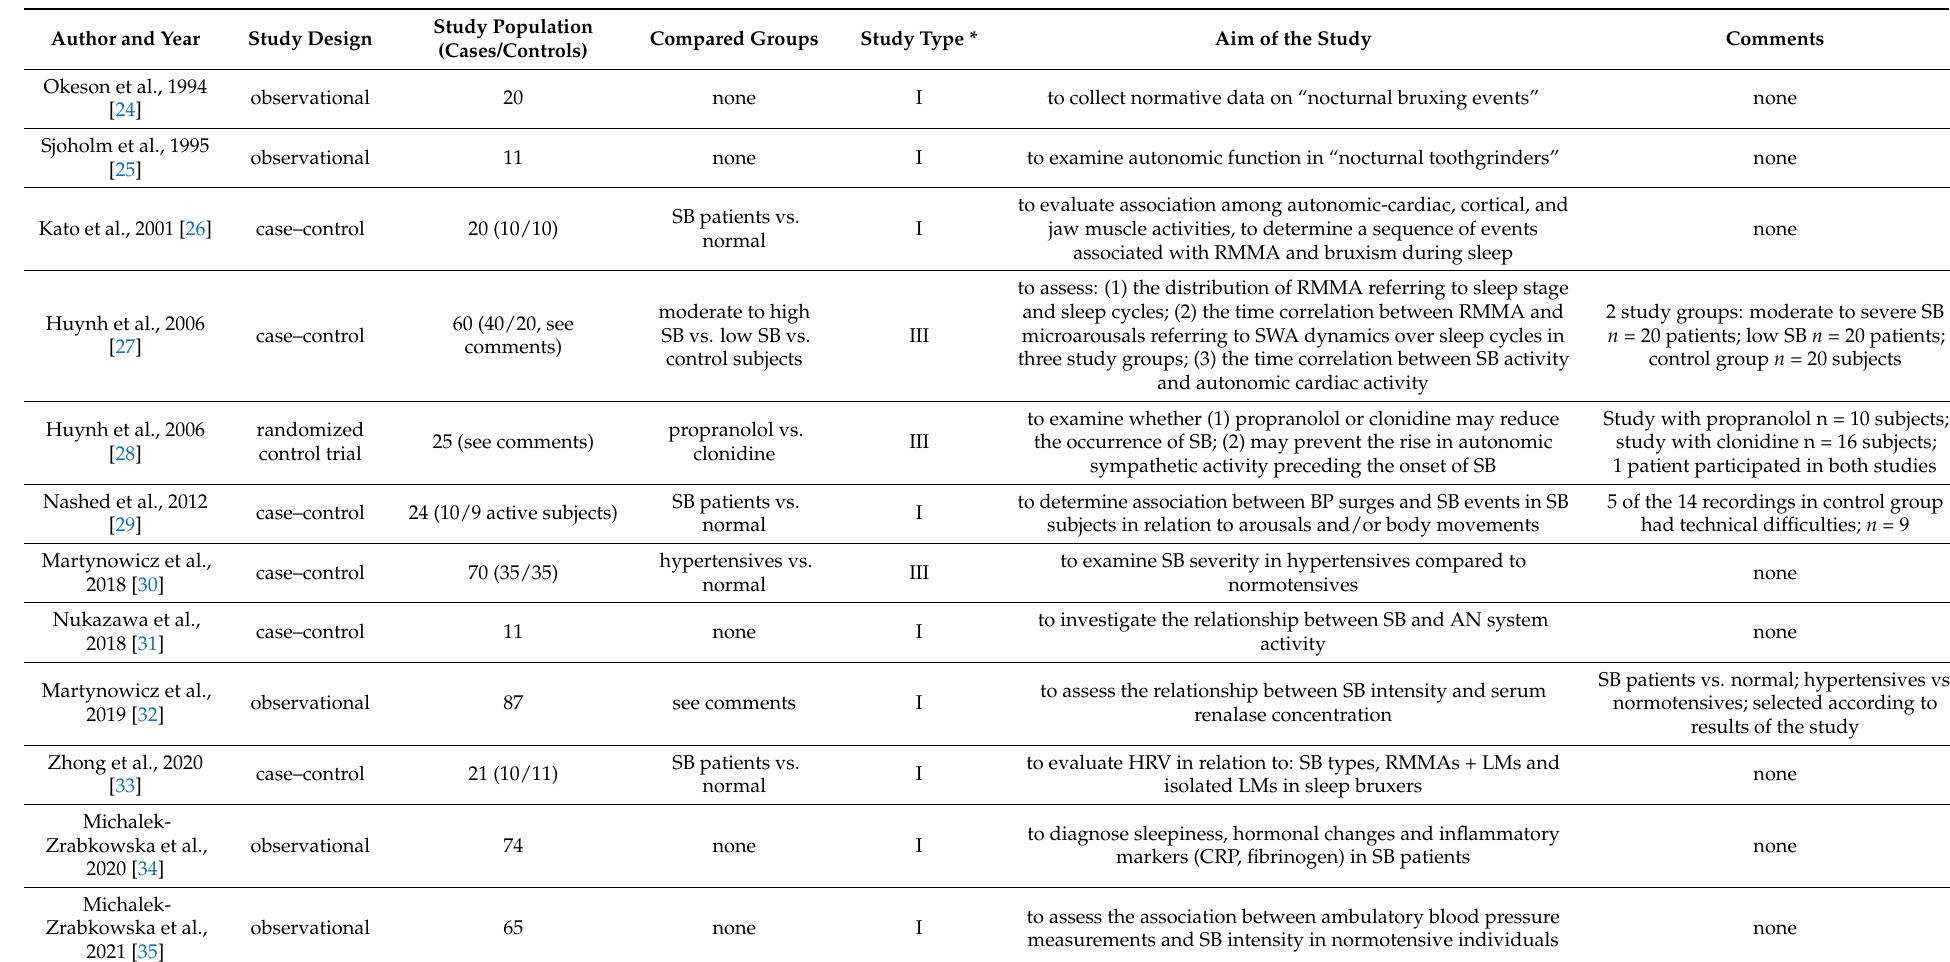
Table 1. The main characteristics of the revised